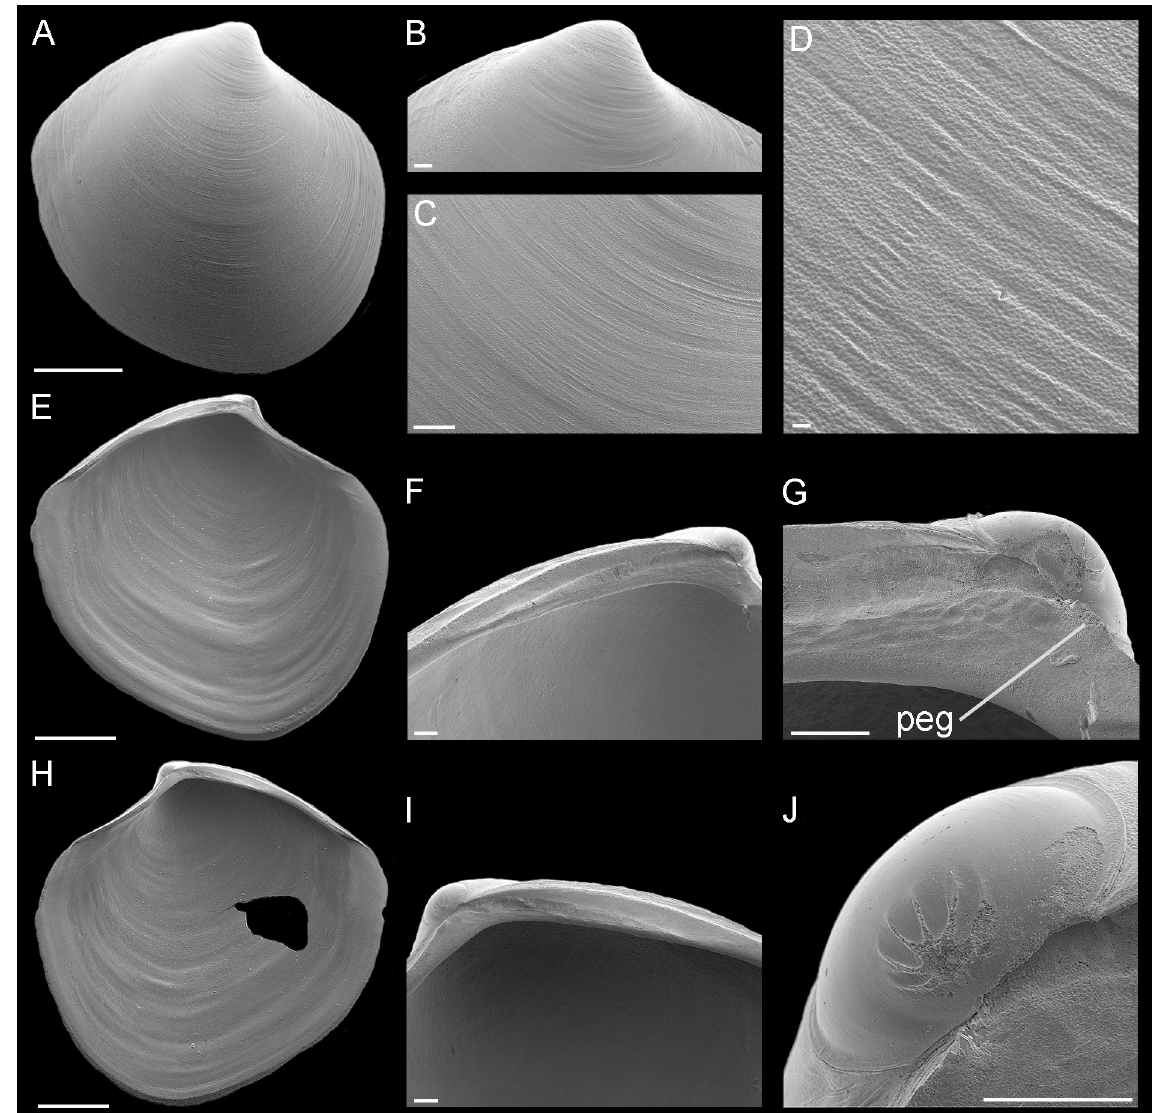
Fig. 9. Scanning electron micrographs of Parathyasira pauli sp. nov. (IORAS OBF collection Cat. BIV00041). A . Exterior view of right valve. B . Sculpture of beak region. C–D . Sculpture of central shell part. E . Interior view of left valve. F . Hinge plate of left valve. G . Pits under beak of left valve. H . Interior view of right valve. I . Hinge plate of right valve. J . Prodissoconch. Abbreviation: see Material and methods. Scale bars: A, E, H = 1 mm; B–C, F–G, I–J = 100 µm; D = 10